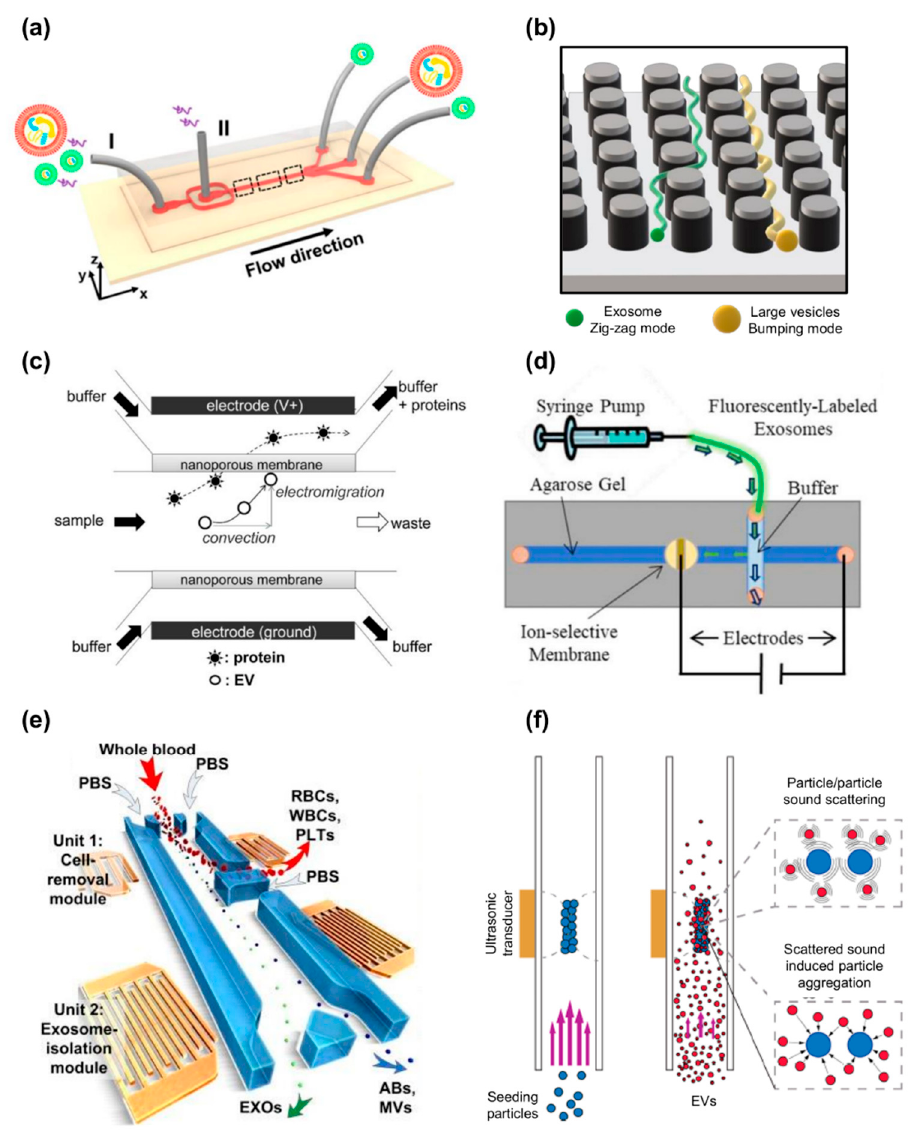
Figure 7. Label-free nanodevices for exosome isolation. ( a ) Schematic illustration of the microfluidic device developed by Liu et al. which exploits lifting forces to separate EVs in a size-dependent manner. Adapted with permission from [199]. Copyright (2017) American Chemical Society. ( b ) Schematic illustration of the microfluidic device realized by Wunsch et al. that uses nanopillar arrays to separate EXOs and other vesicles according to their size [200]. ( c ) Schematic illustration of the microfluidic device presented by Cho et al., which isolates EVs directly from biological fluids by means of electrophoretic migration. Reprinted with permission from [202]. Copyright (2016) Elsevier. ( d ) Schematic illustration of the fluidic device developed by Marczak et al., which uses high transverse electric fields and ion-depleting cation-selective membrane, placed in an agarose gel, to separate EVs of different sizes. Reprinted with permission from [203]. Copyright (2018) John Wiley and Sons. ( e ) Schematic illustration of the acoustofluidic device realized by Wu et al., which exploits SSAW for EXO isolation directly from undiluted blood. Reprinted with permission from [205]. Copyright (2017) National Academy of Sciences. ( f ) Schematic illustration of the acoustic trapping method presented by Ku et al. that exploits ultrasonic transducers to induce reversible clustering between EVs and polystyrene beads which, in turn, facilitates their purification. Adapted with permission from [207]. Copyright (2018) American Chemical